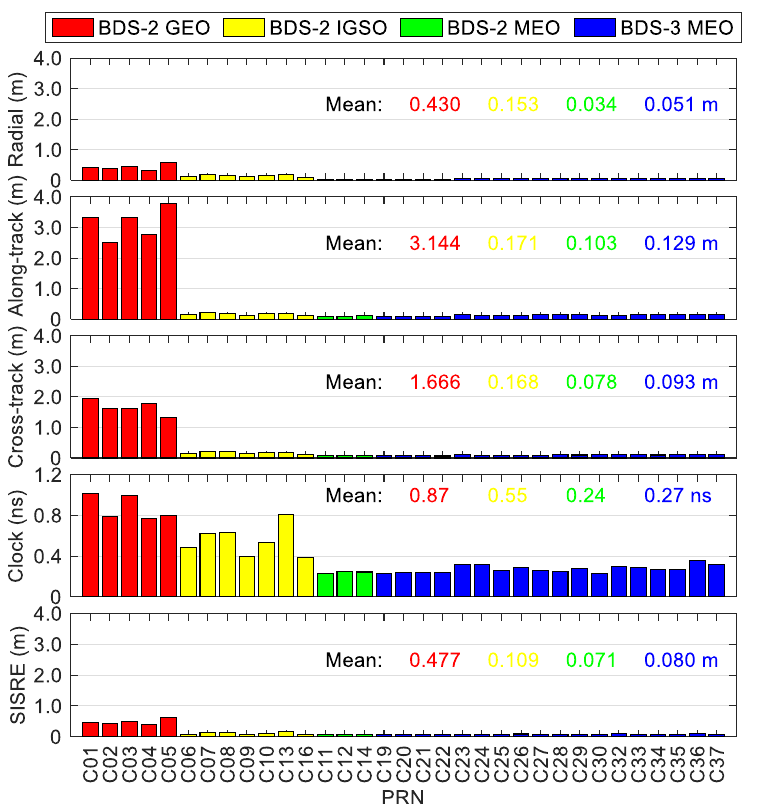
Figure 12. Statistics of errors of BDS-3 / BDS-2 real-time precise satellite orbits and clocks.